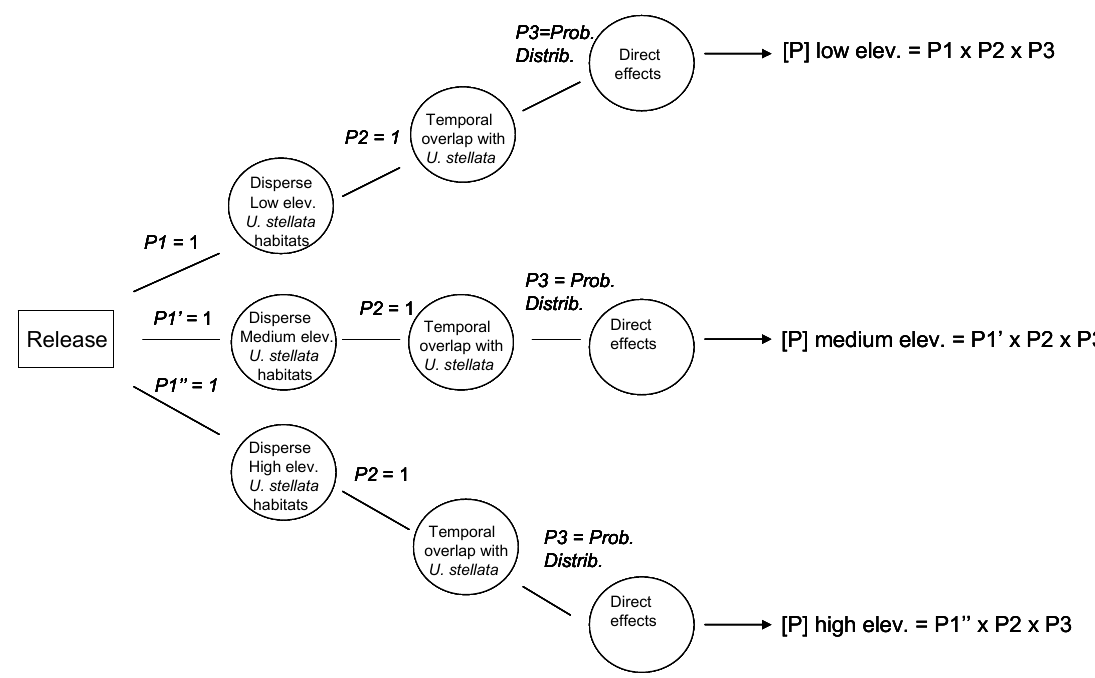
Figure 2. General precision tree for worst-case scenario outcomes in terms of non-target impact in Hawaii. P 1 represents the probability of spatial overlap, P 2 represents the probability of temporal overlap, and P 3 represents the probability distribution of all possible outcomes for parasitism (effects on a non-target species). P1, P1’ and P2” refer to p -values associated with each initial dispersal option.